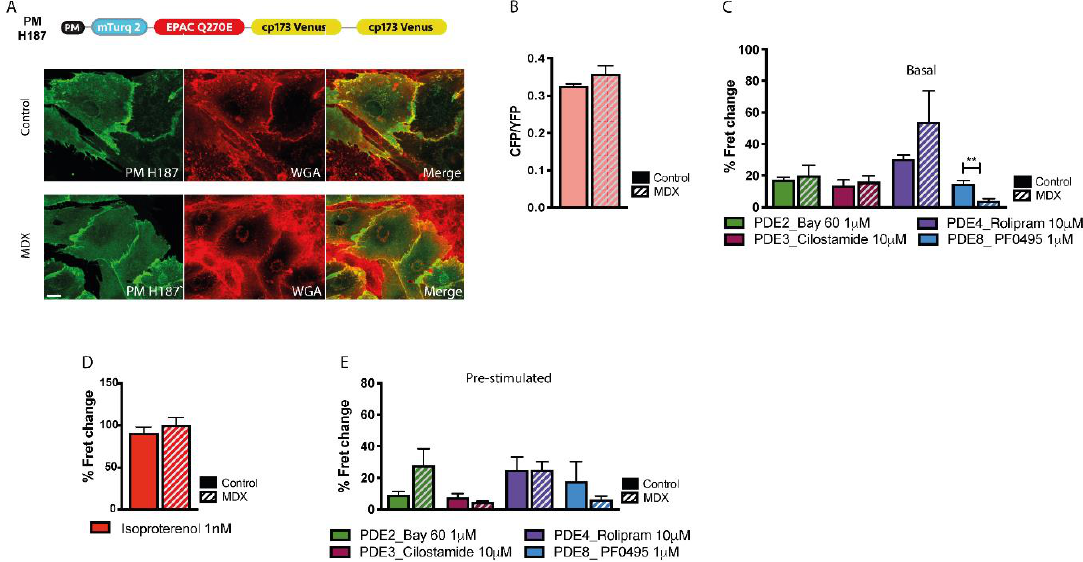
Figure 5. Comparison of cAMP signals at the plasmalemma of NVM from control and mdx mice. ( A ) Top: schematic representation of the plasmalemma-targeted cAMP FRET reporter PM-H187. PM, plasma-membrane targeting domain. Bottom: left, representative images of control and mdx NVM expressing PM-H187. Co-staining with the plasma membrane dye WGA is shown in the central panel and the overlay is shown on the right. ( B ) Mean relative values for CFP to YFP fluorescence intensity ratio recorded in unstimulated NVM from control and mdx mice expressing PM-H187. n = 4. ( C ) Mean FRET change recorded in NVM expressing PM-H187 on application of family-selective cAMP-PDE inhibitors as indicated. n = 4. ( D ) Mean FRET change recorded in NVM from control or mdx mice expressing PM-H187 on application of ISO 1 nM. n = 4. ( E ) Mean FRET change recorded in NVM expressing PM-H187 on application of family-selective cAMP-PDE inhibitors, as indicated, in cells pre-treated with ISO 1 nM. n = 4. For all data, mean ± SEM are shown. ** = 0.001 ≤ p < 0.01. Size bar: 10 µm.